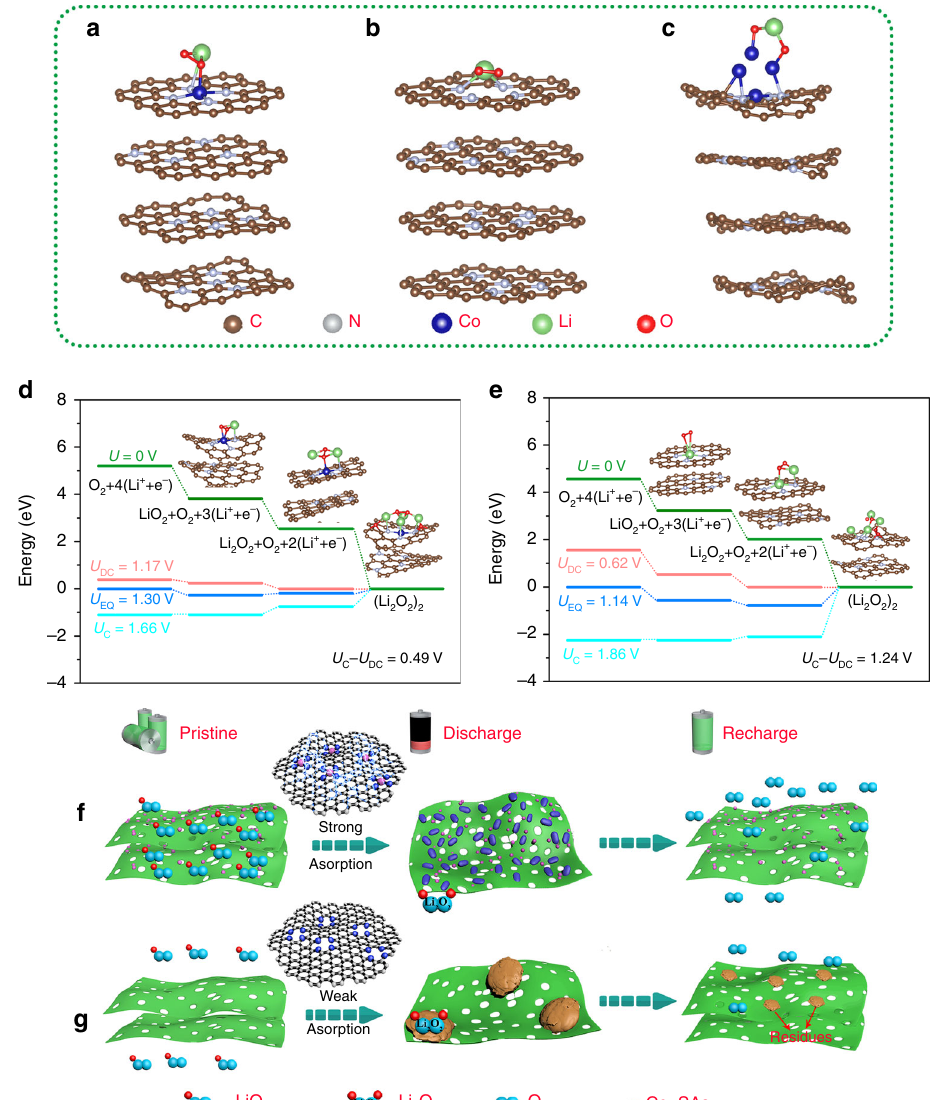
Fig. 5 DFT calculations and proposed mechanisms. a – c The optimized structures of LiO 2 adsorbed on Co-N 4 con fi guration of Co-SAs/N-C, LiO 2 adsorbed on N-C and LiO 2 adsorbed on (111) plane of Co nanoparticle in Co-NPs/N-C. d , e Calculated free energy diagrams for the discharge – charge reactions on the active surface of Co-SAs/N-C and N-C. f , g Schematic illustrations of the working mechanism for the Co-SAs/N-C and N-C